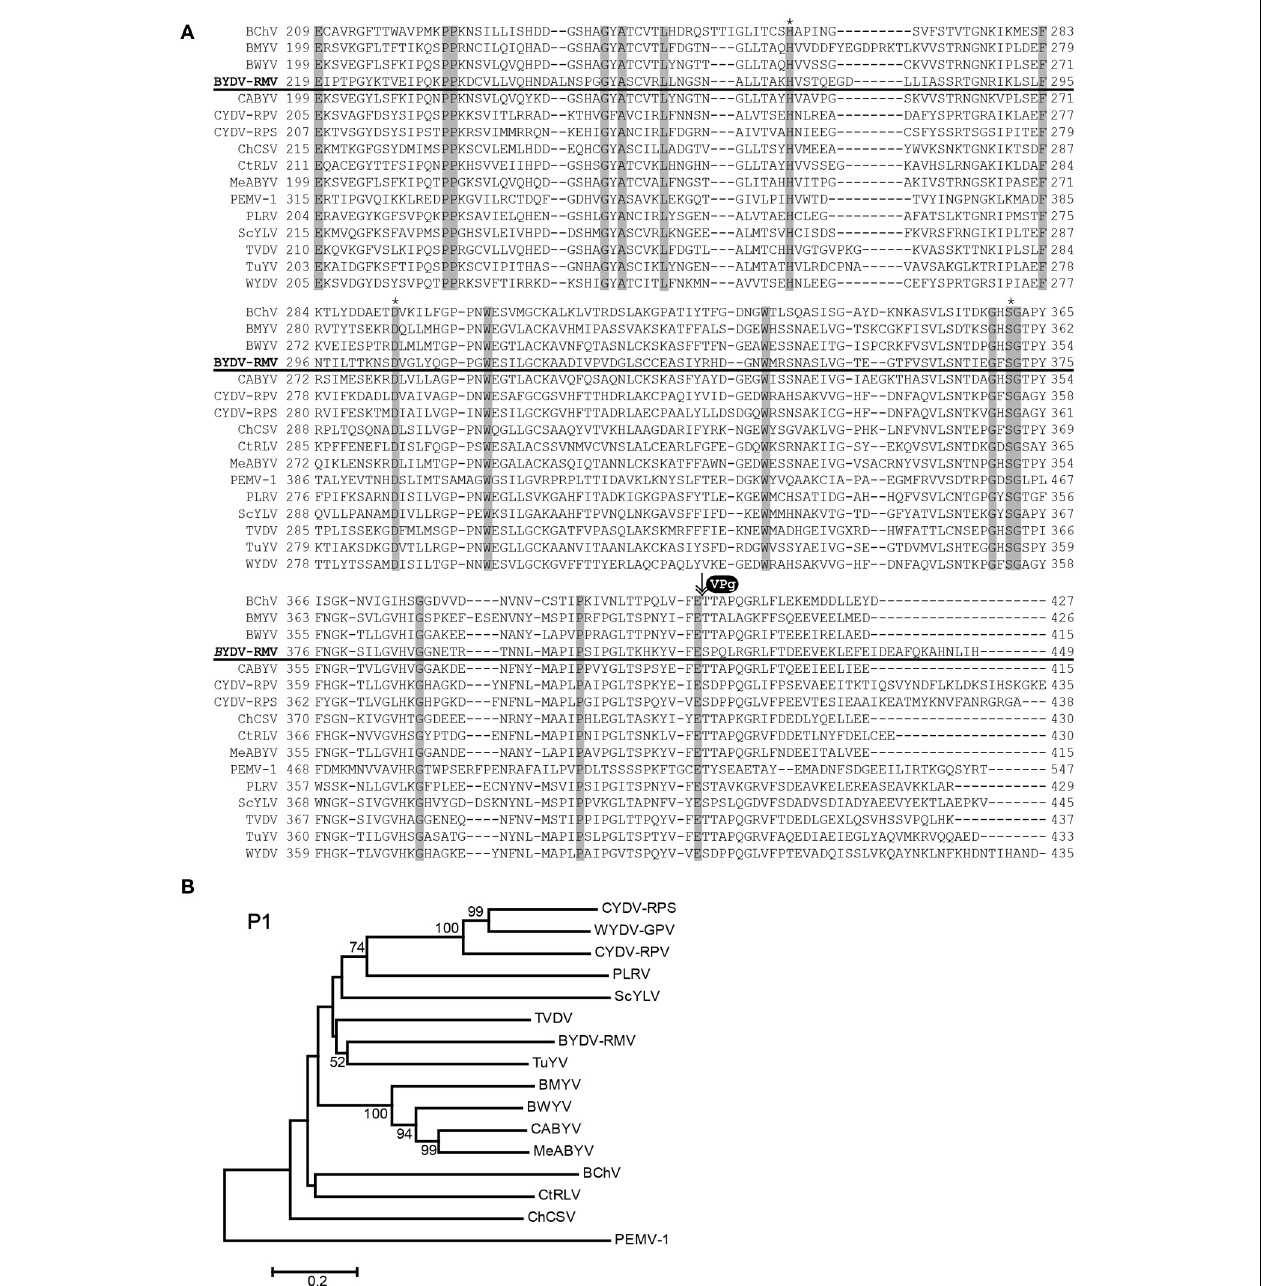
FIGURE 4 | Analysis of P1 amino acid sequences. (A) Amino acid sequences of P1 were aligned with the MUSCLE algorithm within JalView. The region with the protease domain is shown. Shaded boxes indicated conserved amino acids. Asterisks indicate amino acids of the catalytic triad in the protease active site. VPg and arrow indicate predicted proteolytic